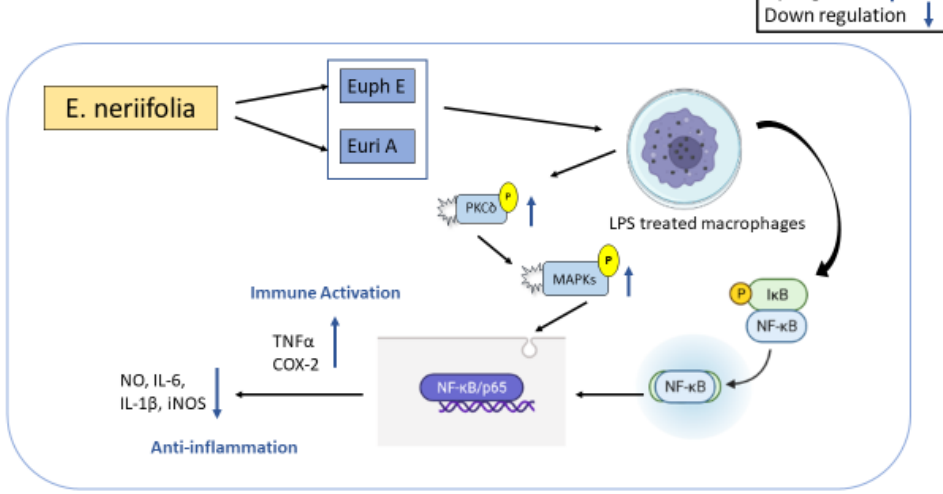
Figure 5. Anti-inflammatory activity of Euphorbia neriifolia .